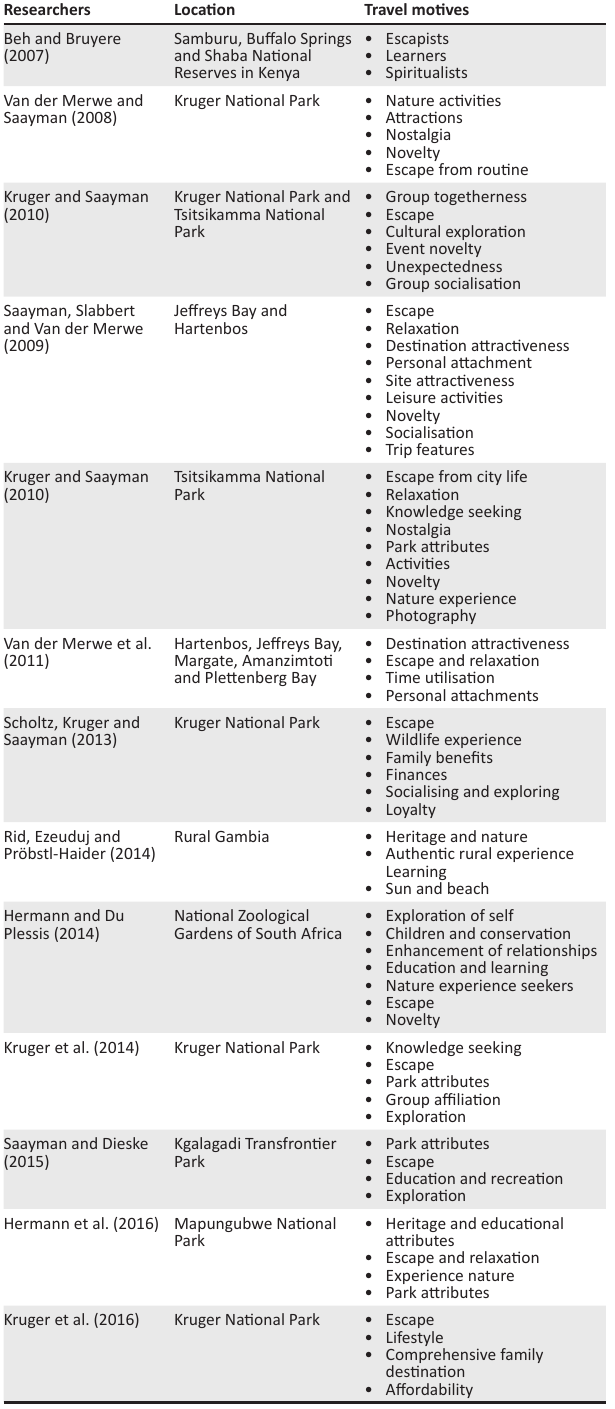
TABLE 1: Summary of travel motivations at nature-based tourism attractions in Southern